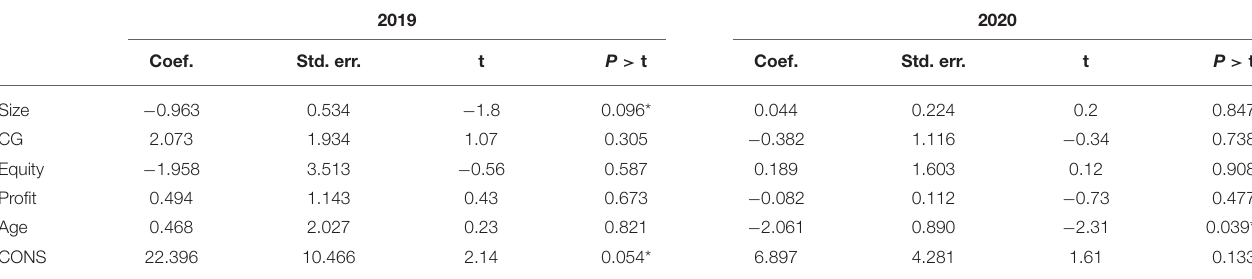
TABLE 12 | The Tobit regression results of factors influencing CSR efficiency under the influence of pandemic.